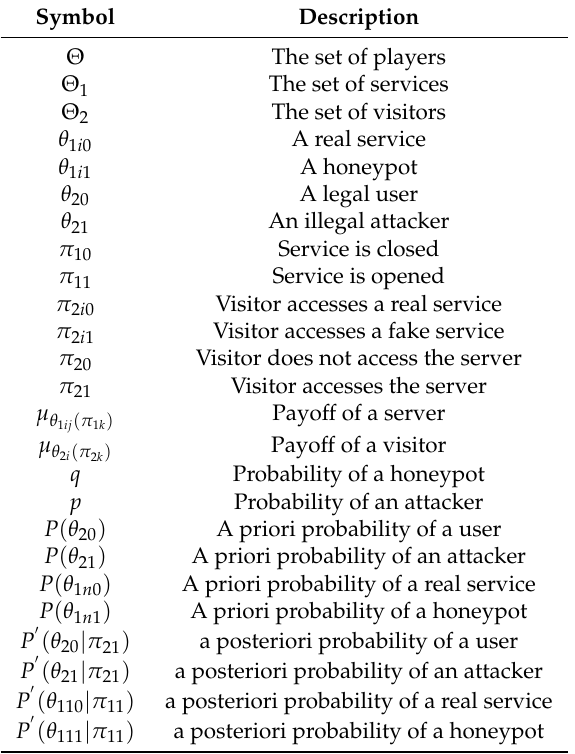
Table 4. Notations used in the